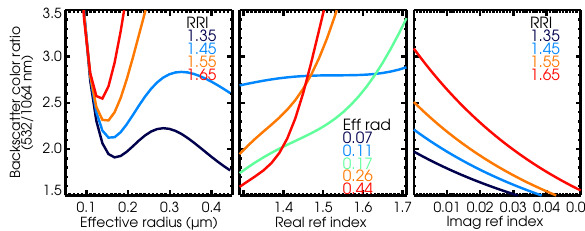
Figure 3. Like Fig. 1 but for the backscatter color ratio (which is the ratio of the aerosol backscatter coefficient at 532nm divided by the aerosol backscatter coefficient at